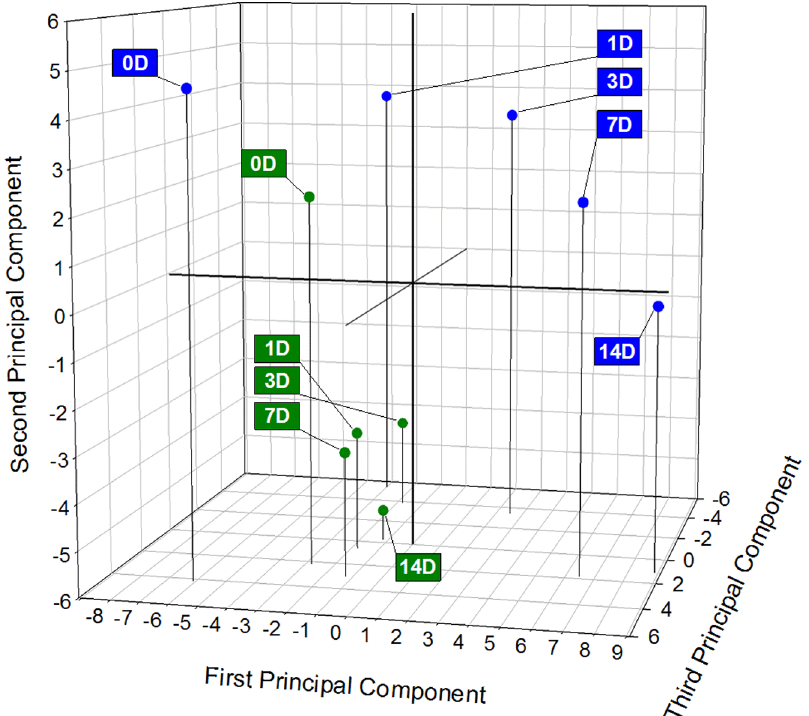
Figure 2. Loading plot with superimposed scores for the first three vectors from principal component analysis of GC-MS detected metabolites from frozen (blue) and control (green) crowns of cold acclimated oats during 0 to 14 days of growth after imposition of